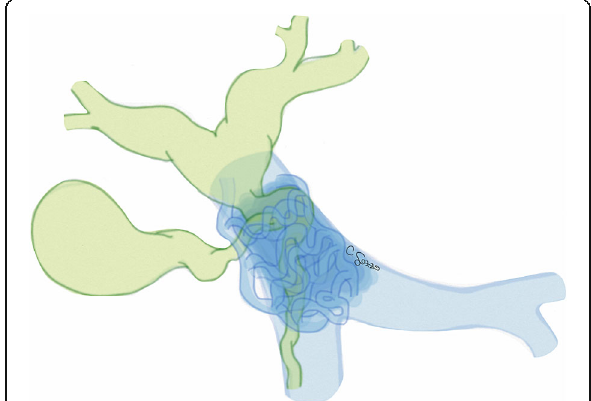
Fig. 18 Drawing illustrating the coronal view of portal biliopathy